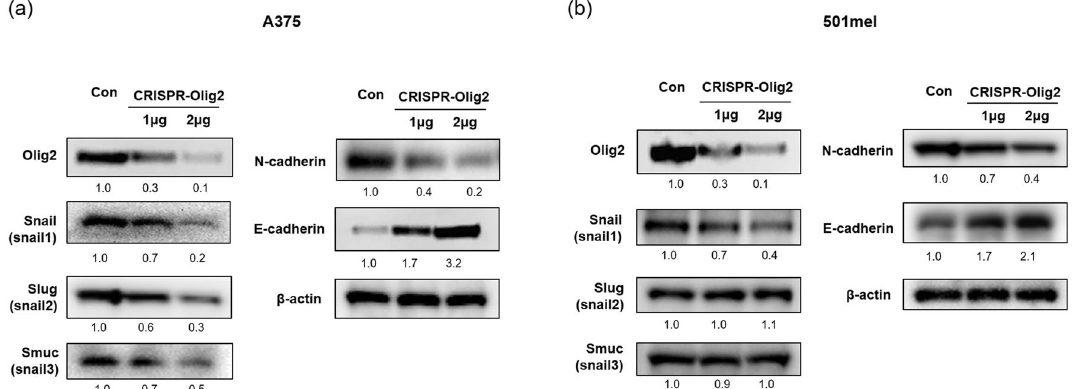
Figure 5. Olig2 regulated the EMT markers in melanoma cells. The expression of EMT markers including Snail, Slug, Smuc, N-cadherin and E-cadherin was detected in ( a ) A375 cells and ( b ) 501mel cells using by western blot analysis with Olig2 (H-10) antibody. The band intensity was quantified using NIH ImageJ software 1.45 s and normalized relative to β-actin. Original images of blots were provided in supplementary file.